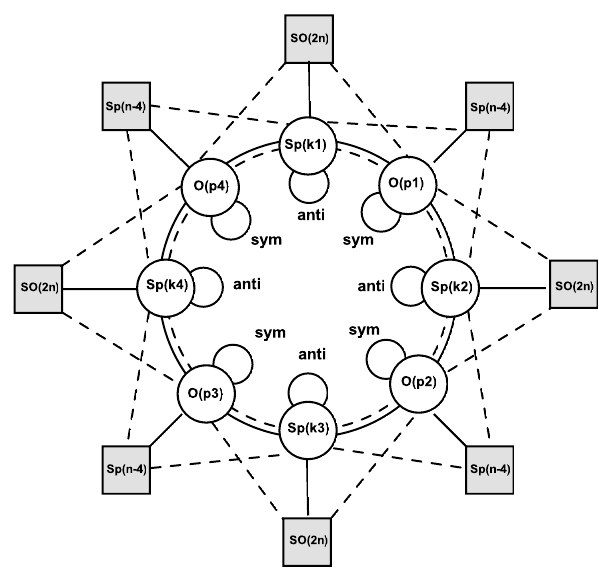
Figure 5 . Quiver for N branes on D n